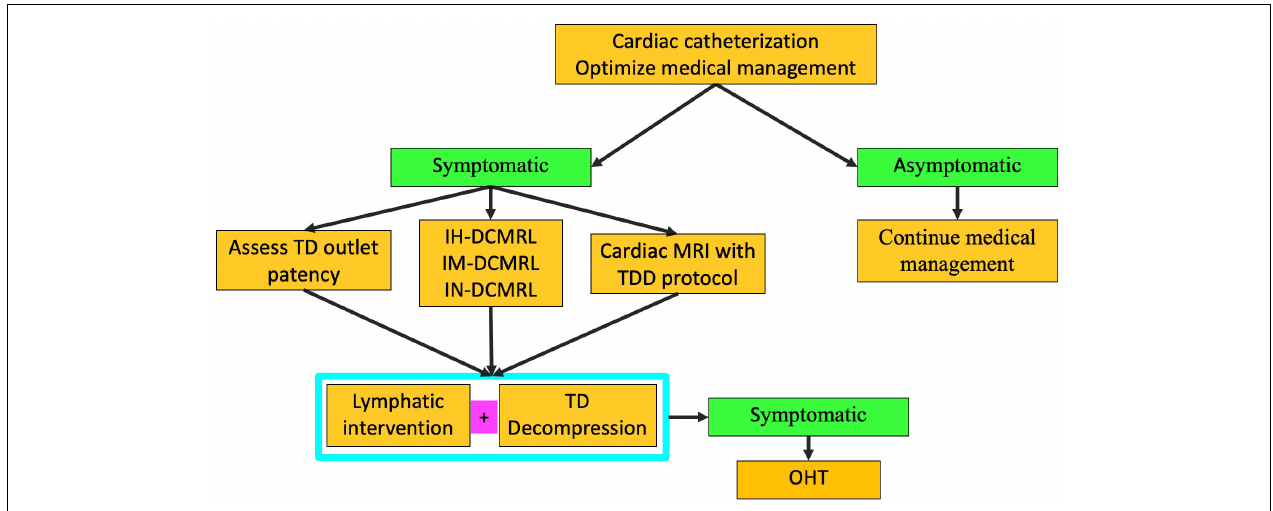
FIGURE 11 | Algorithm for multicompartment failure (TD-thoracic duct, DCMRL-dynamic contrast lymphangiography, IN-intranodal, IH-intrahepatic, IM-intramesenteric, TDD-thoracic duct decompression, OHT-orthotopic heart transplant).